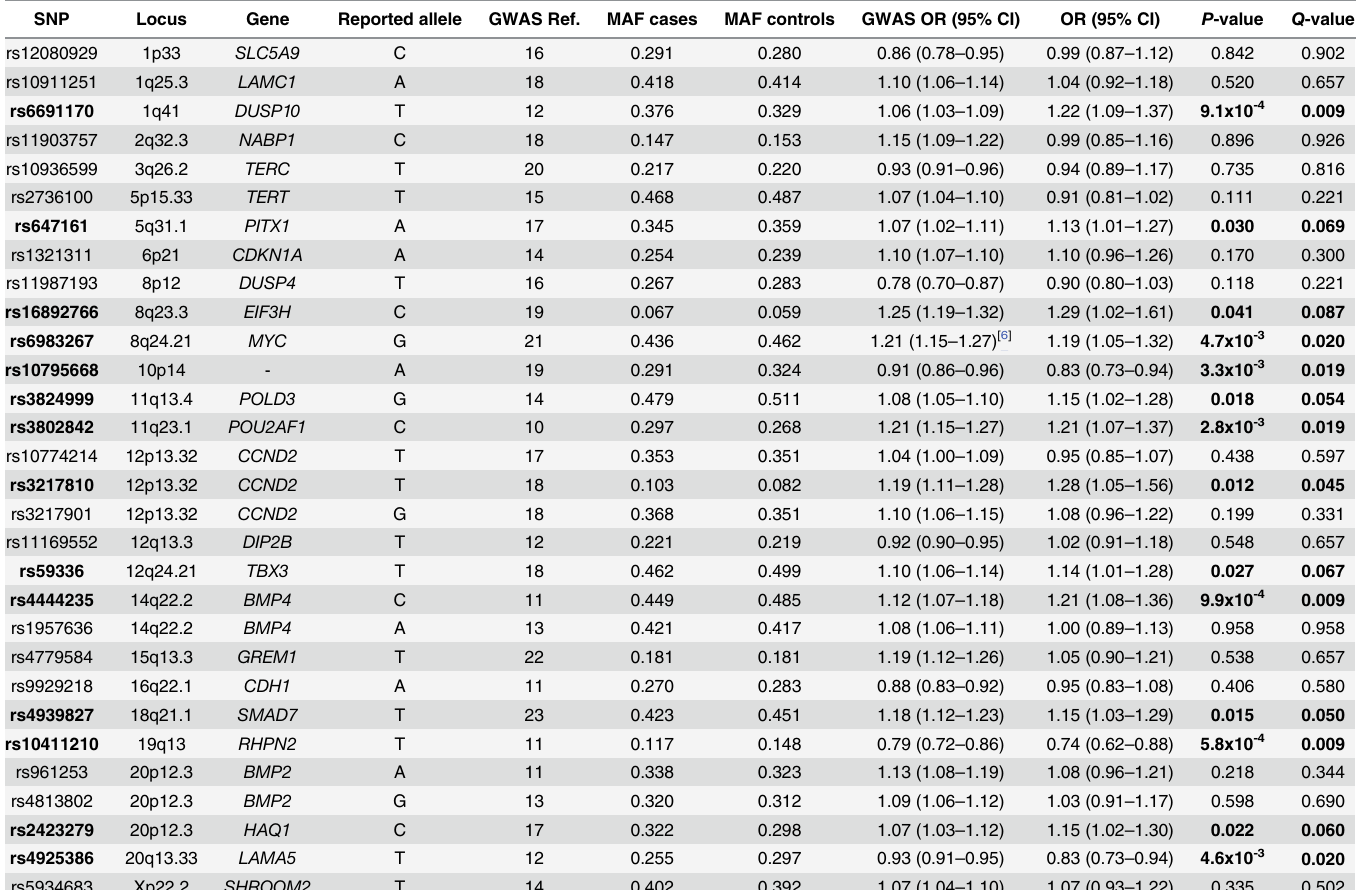
Table 2. Case-control association results obtained by logistic regression analyses adjusted for age and gender. Association results for cases (1,326) vs polyp-free controls (1,266). Results are based on the reported allele from previous CRC GWAS (reference number is shown). Statistically signifi- cant associations are denoted in bold ( P -value < 0.05 and multiple-comparison corrected Q -value <